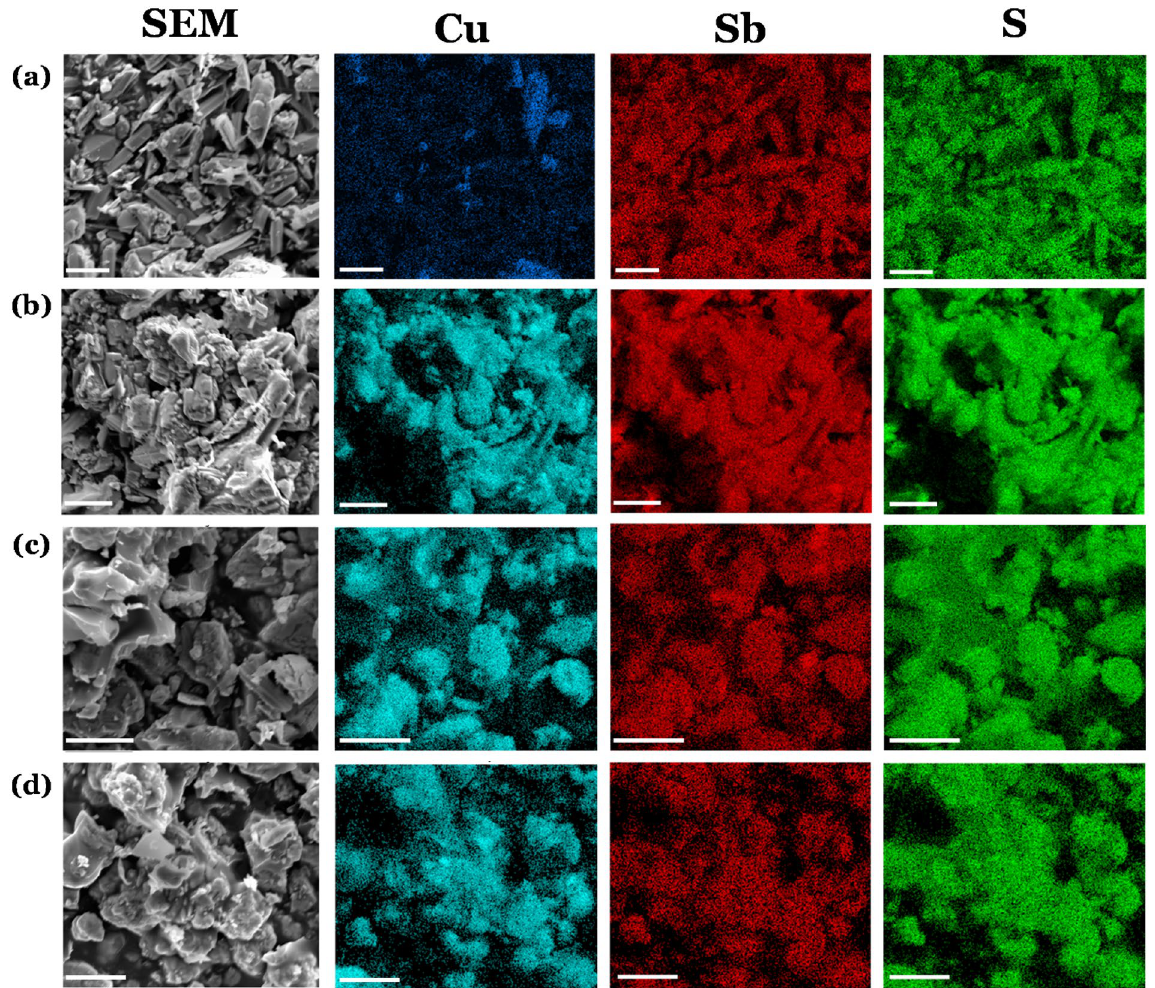
Figure 3. EDX elemental mapping analysis of the various particulate Cu 2x Sb 2(1−x) S y systems prepared by solventless thermolysis at 450 °C for 1 h, where x = ( a ) 0.2, ( b ) 0.4, ( c ) 0.6 and ( d ) 0.8. Elemental mapping is also shown for (green) sulfur (Kα), (blue) copper (Kα) and (red) antimony (Lα). These were recorded at 15 k eV using secondary electron SEM. All scale bars presented correspond to 10